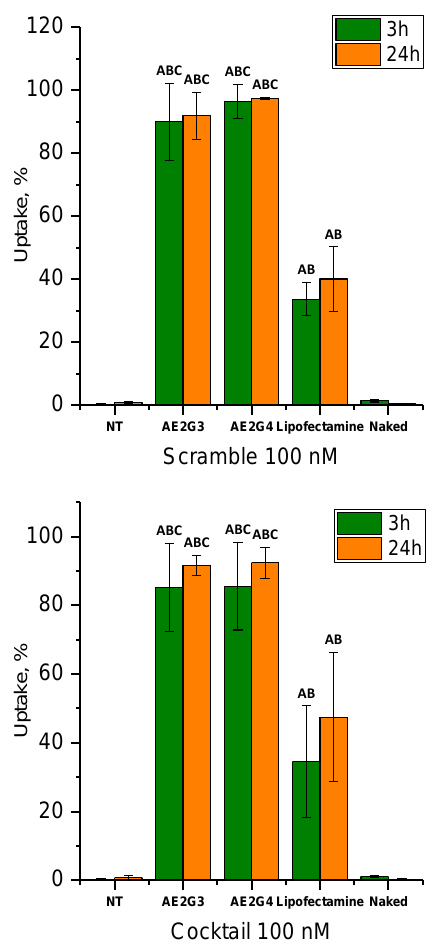
Figure 2. Cellular uptake of 100 nM scrambled siRNA ( top panel ) and 100 nM pro-apoptotic siRNA cocktail (1/3 siBCL-2, 1/3 siBCL-xL, 1/3 siMCL-1; ( bottom panel ) mediated by AE2G3, AE2G4